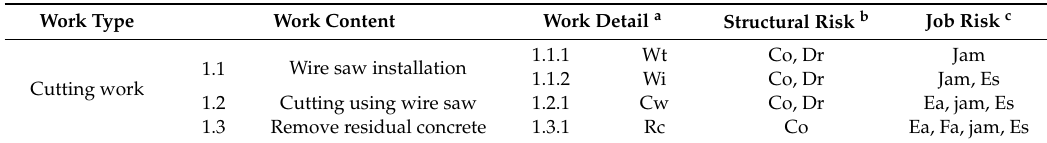
Table 5. Potential risks of the cutting